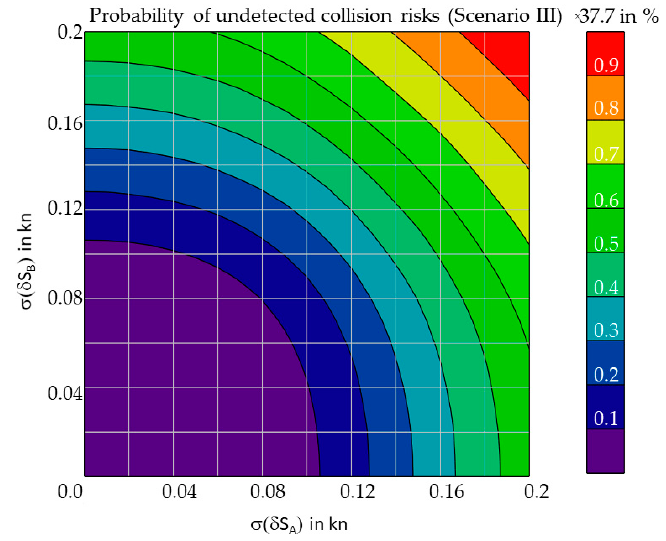
Figure 10. Probability of undetected collisions risks (colour-represented value range between 0 and 37.7%) dependent on the standard deviation of SOG inaccuracies with values between 0 and 0.2 kn ( ϕ A - ϕ B =+ π /4; L = 100 m; δ t = 18